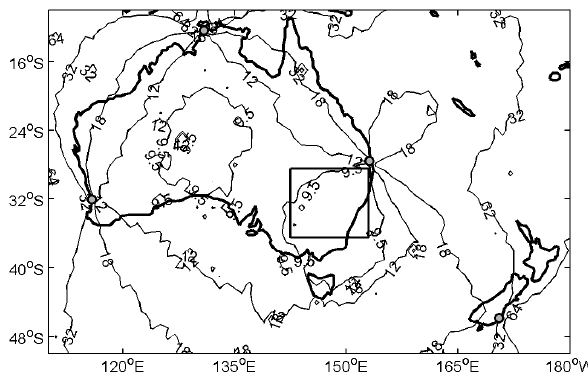
Fig. 8. The estimated location accuracy of the WWLL network when including only the 4 stations nearest to the Kattron high accu- racy region in the same format as Figure 1. A 35 µ s timing error is assumed for the